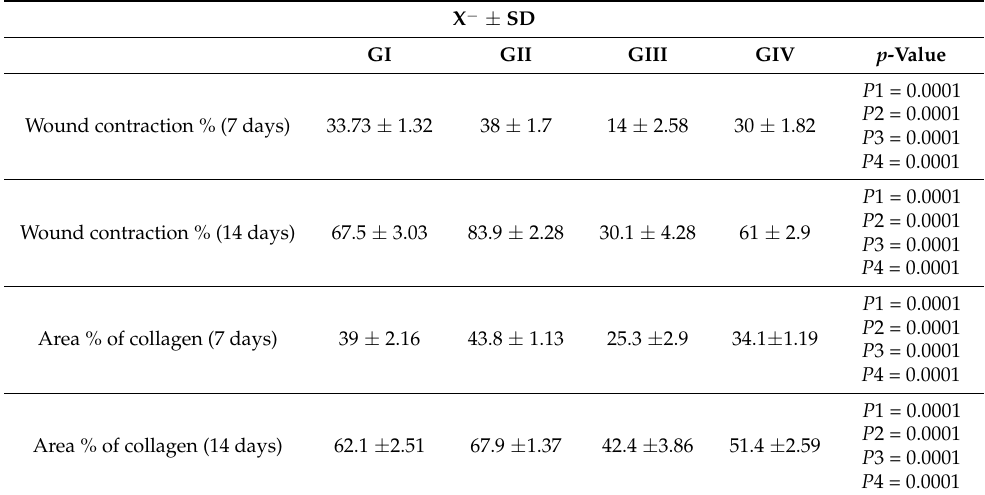
Table 3. Percentage of wound contraction and area percentage of collagen in different groups.